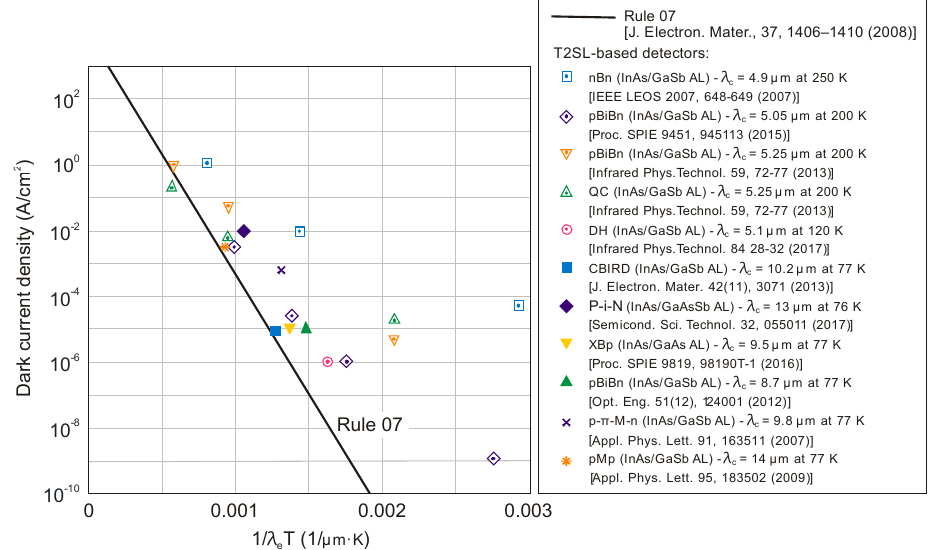
Figure 67. Comparison of various types InAs/GaSb SL detectors with the “Rule 07”.